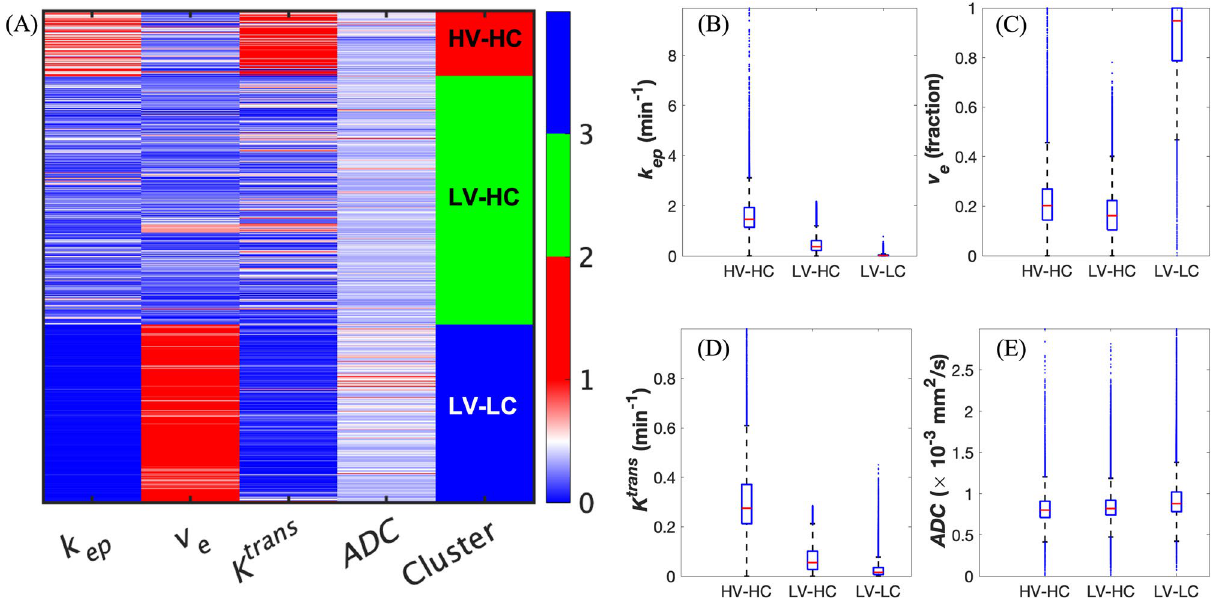
Figure 3. Identification of three tumor habitats with k -means clustering. ( A ) This is the heat map of normalized quantitative parameters grouped by the three identified clusters: high-vascularity high-cellularity (HV-HC), low-vascularity high-cellularity (LV-HC), and low-vascularity low-cellularity (LV-LC). ( B ) Boxplots of the distributions of k ep are presented for each identified habit, where the red line in each boxplot represents the median of the distribution. Analogous to ( B ), panels ( C - E ) show the distributions of v e , K trans , and ADC, respectively. 168,207 voxels were included in this clustering analysis. We found that all four parameter distributions differ significantly between the three habitats, with p < control and treated cohorts, respectively, are displayed in Fig. S3 at multiple imaging visits. Quantitatively, MSI analysis (Fig. S4A-D) verifies that the habitats are spatially contiguous. Calibration of the family of mathematical models. The tumor habitat time series from all 16 rat datasets were used to calibrate each of the four mathematical models [Eqs. (1)–(4), Fig. 2]. The calibrated model parameters for Model A (the parent model) are presented in Table S3, and we found that the d 21 , d 13 , and θ parameter distributions are significantly different between the control (C) and treated (R) cohorts. Additionally, in Table S3, we observed that the model parameters d 21 and d 13 are one to two orders of magnitude smaller com- pared to the other model parameters, prompting the development of the additional three models that exclude these two model parameters. Panels A-D of Fig. 5 show all four models calibrated to the habitat times series of four representative rats from the control group, while panels E–H show these calibrations for four representative rats from the treated group (See Figs. S5 and S6 for all 8 control and all 8 treated rat calibrations, respectively). There were no statistical differences in the SSEs for all models when compared within identical habitats. Moreover, the four CCC values (Fig. S7) (one for each model) are all above 0.95, indicating strong agreement between the four models and the data that they were calibrated to. Selecting the most parsimonious model. The AIC values were computed using a MATLAB implemen- tation of Eq. (5) for each of the four calibrated models across all 16 habitat time series, resulting in four AIC val- ues per rat that are collected in Table S4. Model D consistently yielded the lowest AIC for all rat datasets, which is why Model D was selected as the most parsimonious model relative to the other three models (see Table S5 for model parameter values). Because the four models performed similarly (Figs. 5, S7), Model D was selected because it had the least number of parameters. Thus, Model D is used for the remaining analyses in this study. Prediction and validation of tumor habitat dynamics. Treating each tumor habitat time series inde- pendently as a validation dataset, we applied the LOO and bootstrapping methods to evaluate the ability of Model D to predict the habitat dynamics. To select the appropriate number of samples, N b , in bootstrapping, we performed the bootstrapping method for different values of N b , plotted the resultant SSEs against N b , and aver- aged the results across all rats in the control (Fig. S8A) and treated (Fig. S8B) cohorts. We qualitatively inspected the plots in Fig. S8 to arrive at N b = 200 as an appropriate sample size at which the SSE values have stabilized and additional samples do not improve the prediction. Figure 6 shows the results of the predictions for a representative rat. The calibrated model in Fig. 6A is jux- taposed with the LOO predictions (Fig. 6B–D) and the bootstrapping predictions (Fig. 6E–H). Using the initial tumor volume (Fig. 6B) and tumor composition (Fig. 6C) as weighting schemes in the LOO approach resulted in